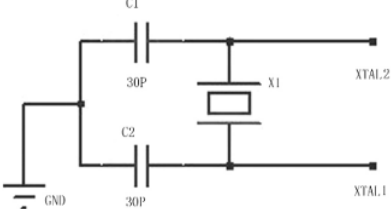
Fig. 2. Single chip clock circuit diagram of control